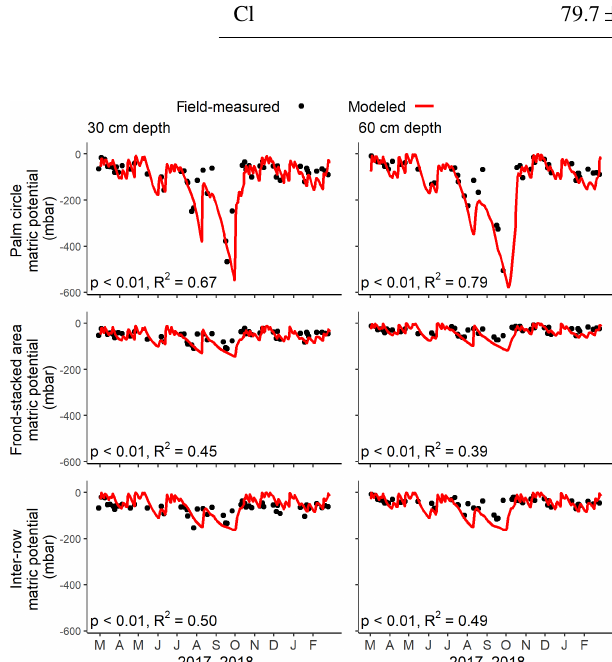
Figure 1. Pearson correlation test between modeled (red line) and field-measured (black points) soil water matric potential ( n = 50 field measurements over 1 year) for each management zone at 30 and 60cm depths.